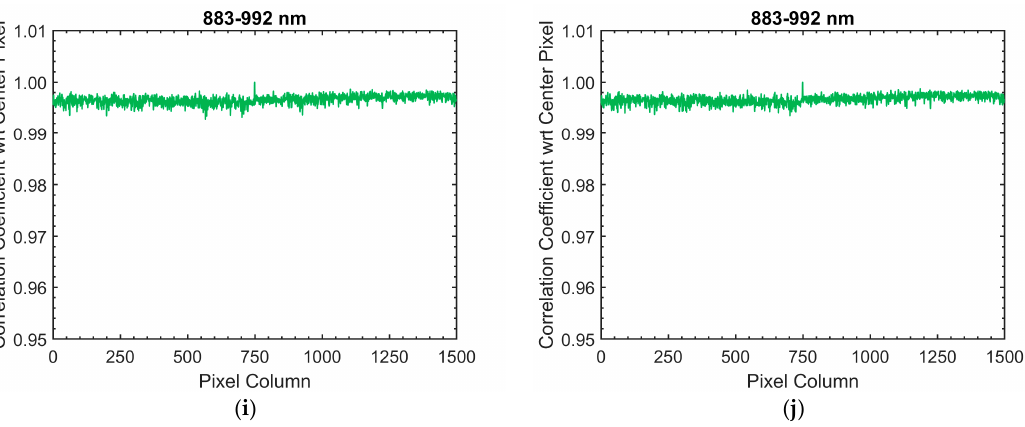
Figure 18. The CCs calculated across the field-of-view of the CASI imagery with respect to the spectrum from the center pixel. The wavelength regions used to calculate the CCs are identified in each graph and correspond to the values in Table 4. Plots ( a , c , e , g , i ) correspond to the CASI data that were processed with the original methodology. Plots ( b , d , f , h , j ) correspond to the CASI data that were processed with the refined methodology. ( a,b ) The CCs for the 680–712 nm region were highly variable with a low frequency sinusoidal structure. ( c,d ) The CCs for the 710–745 nm region were relatively constant across the FOV. A distinct reduction was detected in the CC of a single pixel near the right edge for the imagery processed with the original methodology, but not the refined processing. ( e,f ) There was a reduction of approximately 0.021 in the CC for the 750–775 nm region near the edges of the FOV. This effect is likely caused by the smile effect or other cross-track illumination effects. ( g,h ) For the data from the 804–846 nm window of the imagery processed with the original methodology, there were characteristic reductions in the CC greater than 0.05 detected. These reductions revealed potential imaging errors for the spectral window in the following spatial ranges: 256–276, 551–576, 912–936 and 1209-1235. These reductions were not present in the CCs for the image derived with the refined processing. ( i,j ) In the 883–992 nm region, the CCs were relatively constant across the FOV.